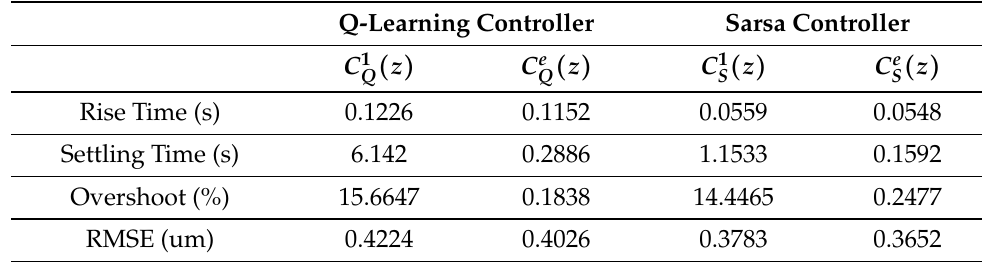
Table 3. Statistical comparison of the